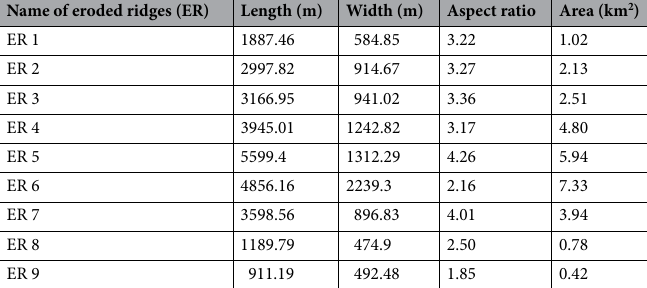
Name of eroded ridges